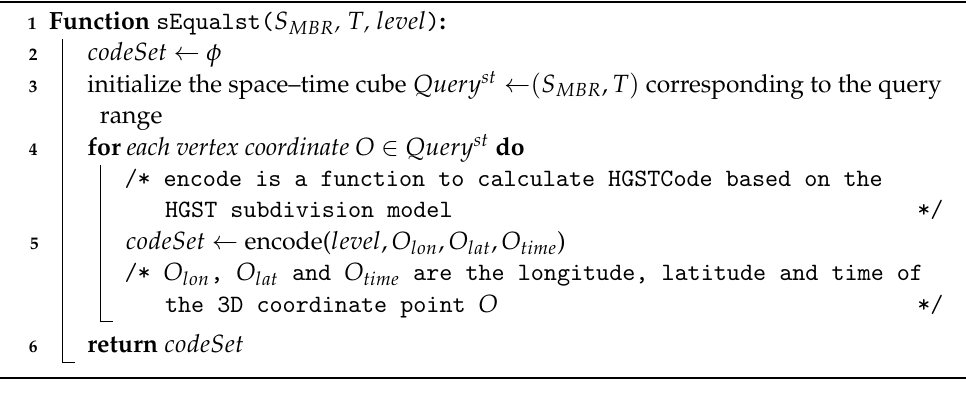
Algorithm 2: The query on the same temporal and spatial scale